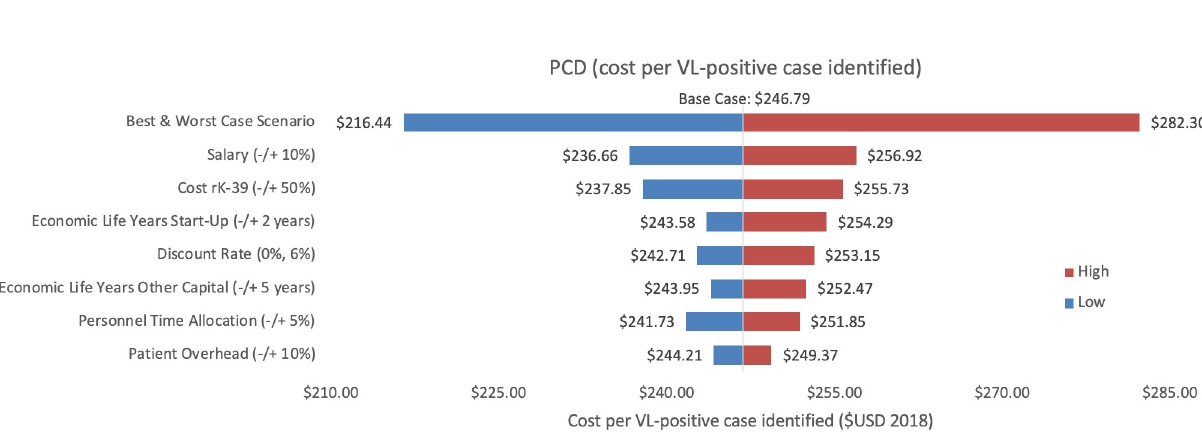
PLOS NeglectedTropical Diseases | https://doi.org/10.1371/journal.pntd.0009129 February 3,